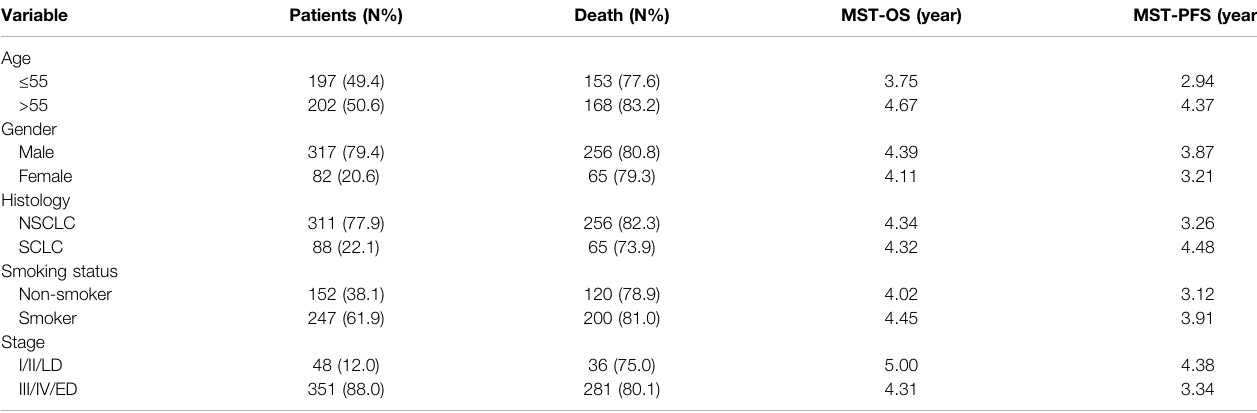
TABLE 2 | Distribution of characteristics in patients with patients with lung cancer and prognosis analysis. Variable